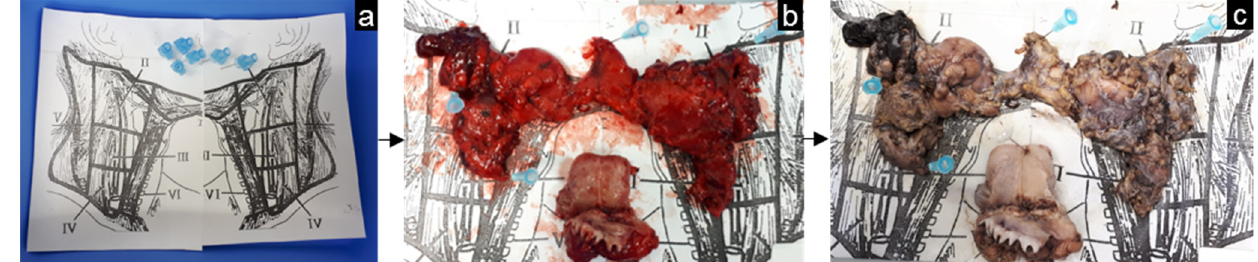
Figure 7. Example of tissue fixation in head-and-neck cancer. A grid containing a reference drawing of the neck including the levels ( a ) was present at the operating room. After resection, the fresh specimen was pinned to this grid ( b ) and was subsequently fixated with formalin at the Department of Pathology ( c ).